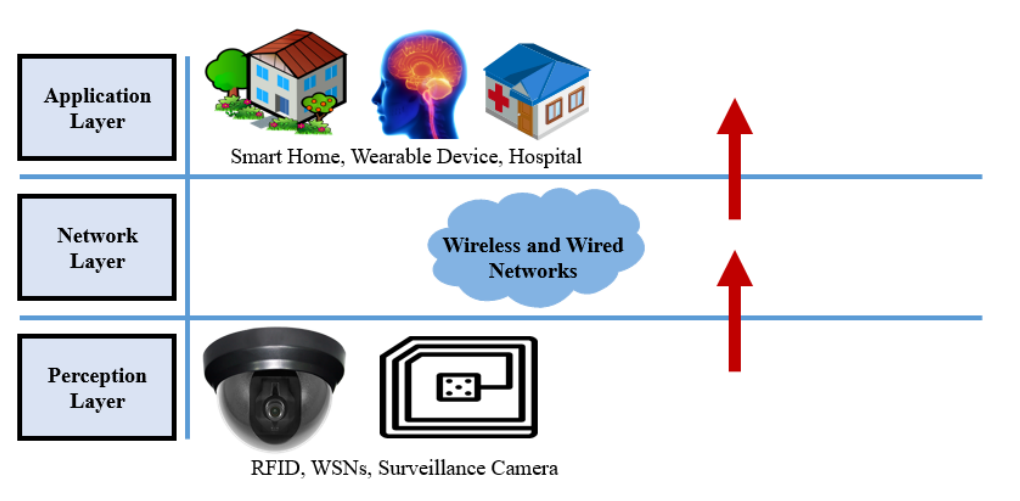
Figure 4. The three-layered architecture of